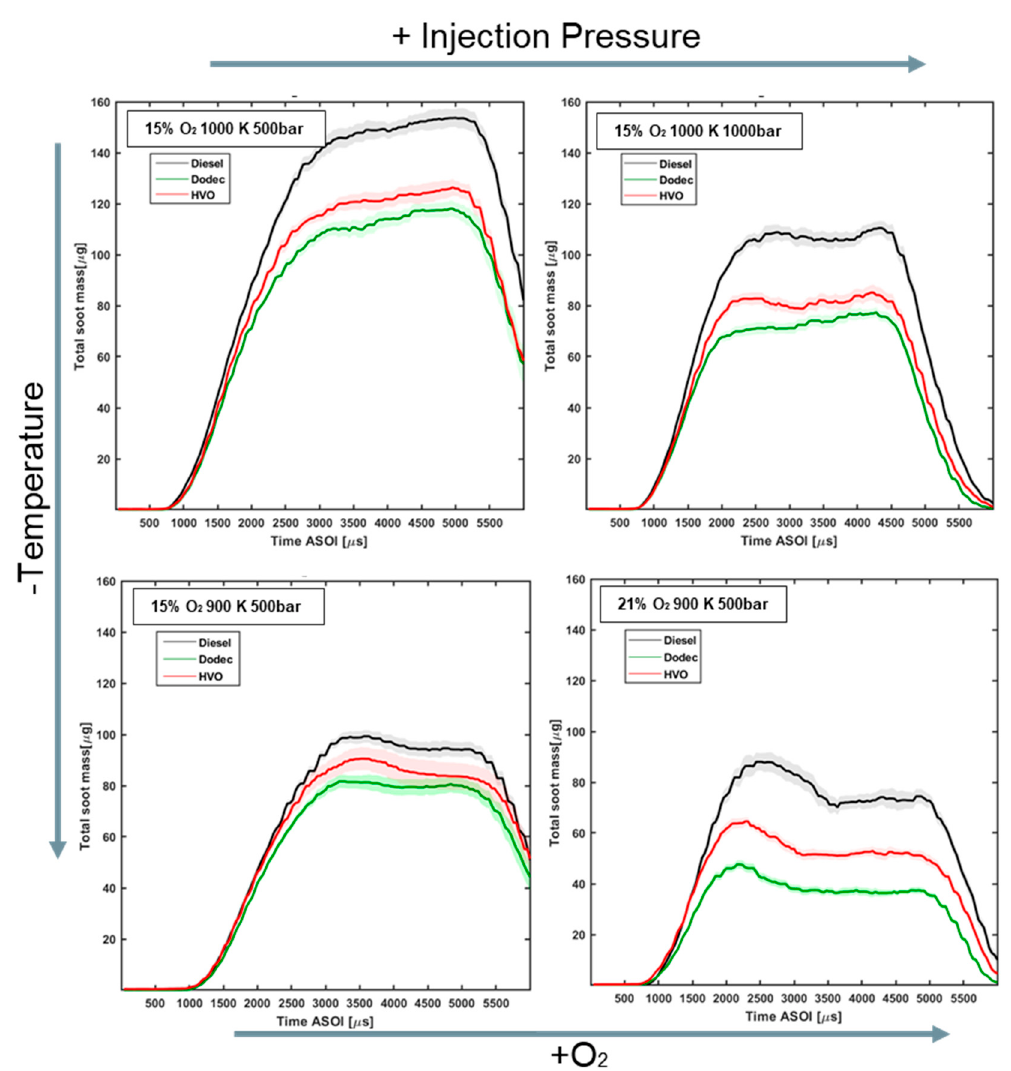
Figure 13. Influence of the variation of injection pressure, temperature and oxygen concentration on the total soot mass.